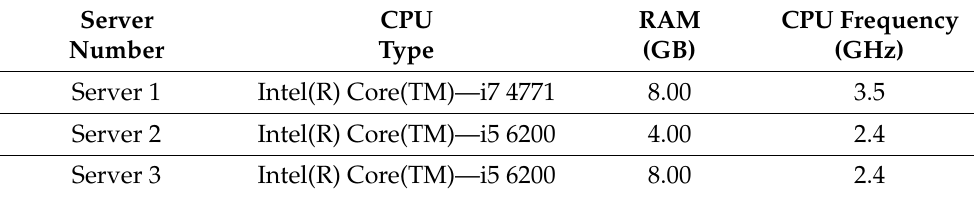
Table 3. Hardware characteristics of the servers used for the simulation analyses.